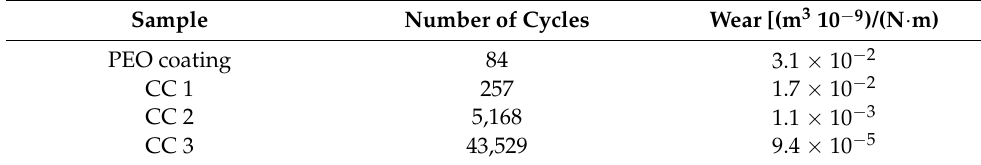
Table 3. The wear of samples made of AMg3 aluminum alloy with various types of surface treatment.